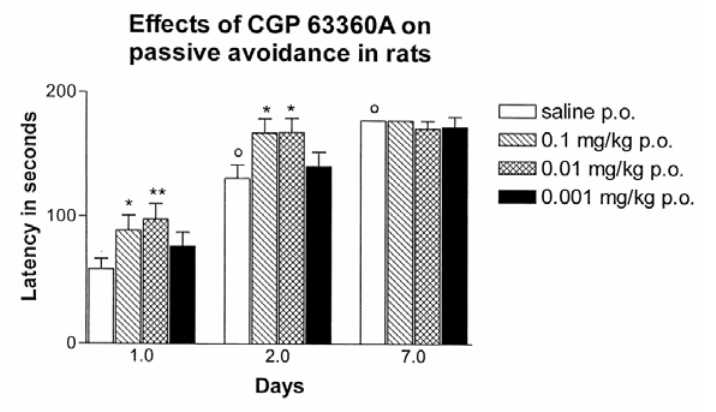
Fig. 4 Effects of GABA B receptor antagonist CGP63360A on learning and memory re- tention in rats on passive avoidance test. Abscissa - days of testing; Ordinate - latency(s). o P < 0 . 05 compared to the 1 st day control. ∗ P < 0 . 05 and ∗∗ P < 0 . 01 compared to the respective